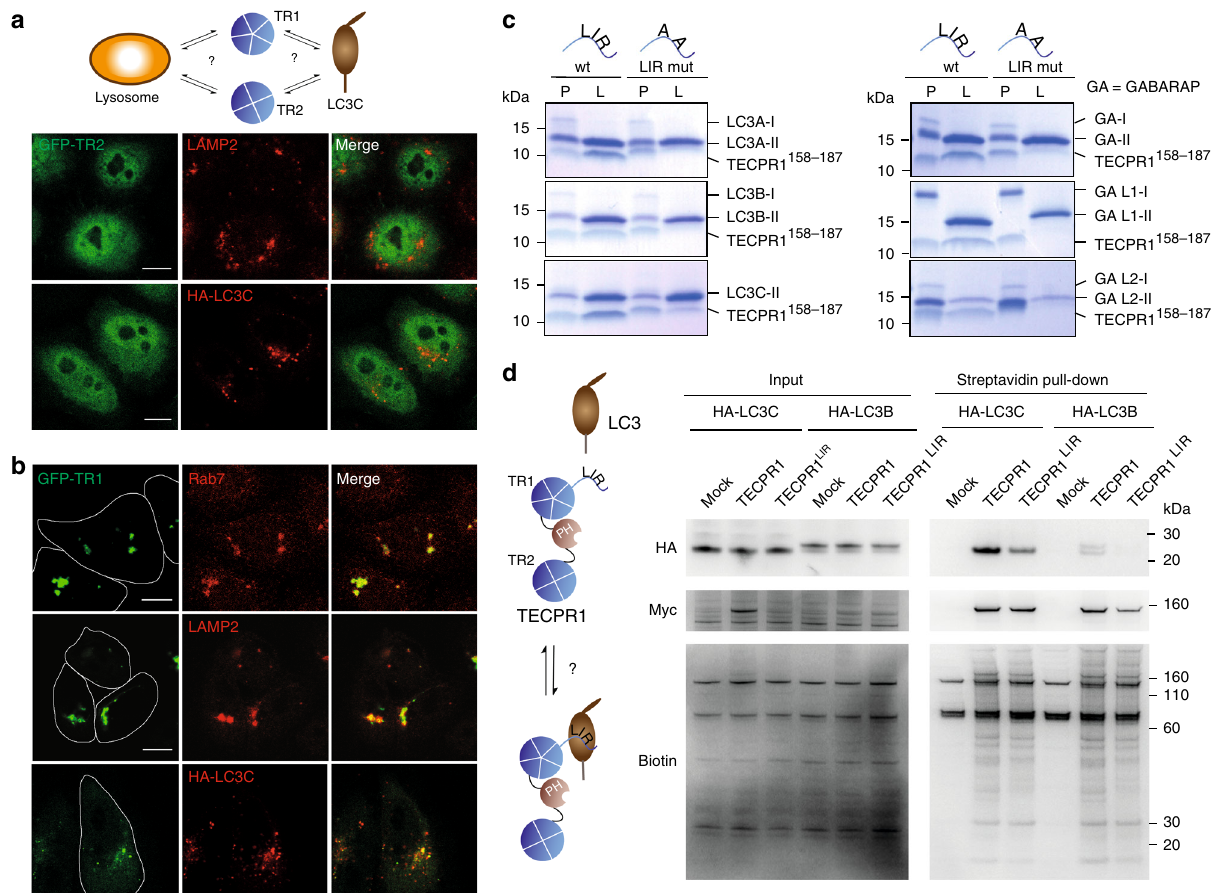
Fig. 2 TECPR1 possesses an LC3-interacting motif. a Colocalization of immunostained LAMP2 and HA-LC3C with GFP-tagged TR2 in starved TECPR1 KO cells. Scale bars, 10 µ m. b Colocalization of immunostained Rab7, LAMP2 and HA-LC3C with GFP-tagged TR1 in starved TECPR1 KO cells. Scale bars, 10 µ m. c Floatation assay of small unilamellar vesicles to which the indicated hATG8 variant was conjugated with a peptide (TECPR1 158 – 187 ) that contained the W 175 xxI 178 motif or its corresponding A 175 xxA 178 mutant (LIR mut). The membrane-free protein fractions (P) and the fl oating liposome fractions (L) were collected and analyzed by SDS-PAGE. d BioID assay of TECPR1 KO cells transfected with the empty vector pLPCX (mock), pLPCX-MycBioID-TECPR1 (TECPR1) or pLPCX-MycBioID-TECPR1 W175A/I178A (TECPR1 LIR ), and cotransfected with either HA-LC3C or HA-LC3B. Corresponding cell lysates were precipitated using streptavidin beads and samples were immunoblotted with the indicated antibodies. Source data are provided as a Source Data fi